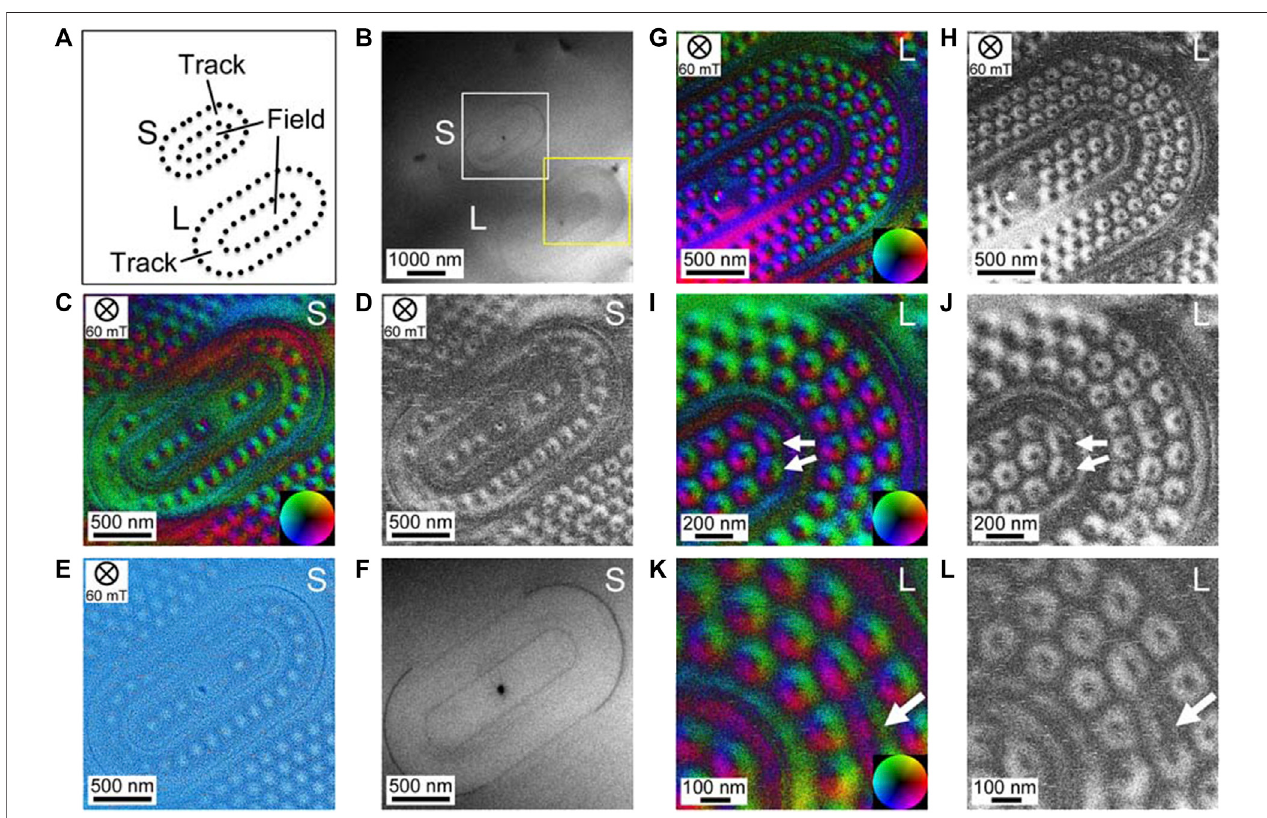
FIGURE 3 | Con fi nement of skyrmions to surface-pit corrals de fi ned by two nested curved boundaries (track and fi eld). (A) Schematic of the two corrals with smaller and larger sizes. (B) Annular dark- fi eld (ADF) imageofthetwo corrals fabricated by afocused electron beam on thesurfaceofthe thin-plate specimen. Thetrack width ofthe smaller corral and that of the larger corral are 420 and 630 nm, respectively. (G) In-plane magnetic induction as a color map and (H) intensity obtained in the area indicated by a white squarein (B) . (C) Magnetichelicityimageand (D) ADFimageofthesmallercorral. (I) In-planemagneticinductionasacolormapand (J) intensitycon fi nedinthelargercorral. Only the fi eld-of-view as indicated by the yellow square in (B) is shown. (E) In-plane magnetic induction as a color map and (F) intensity con fi ned in the larger corral at a higher magni fi cation. (K) In-plane magnetic induction as a color map and (L) intensity con fi ned in the larger corral at a higher magni fi cation. Elongated skyrmions are indicated by white arrows in (E,F,K,L) . The pixel dwell time is 1 ms. The S and L letters at the top-right corner of each image indicate the smaller and the larger corrals,